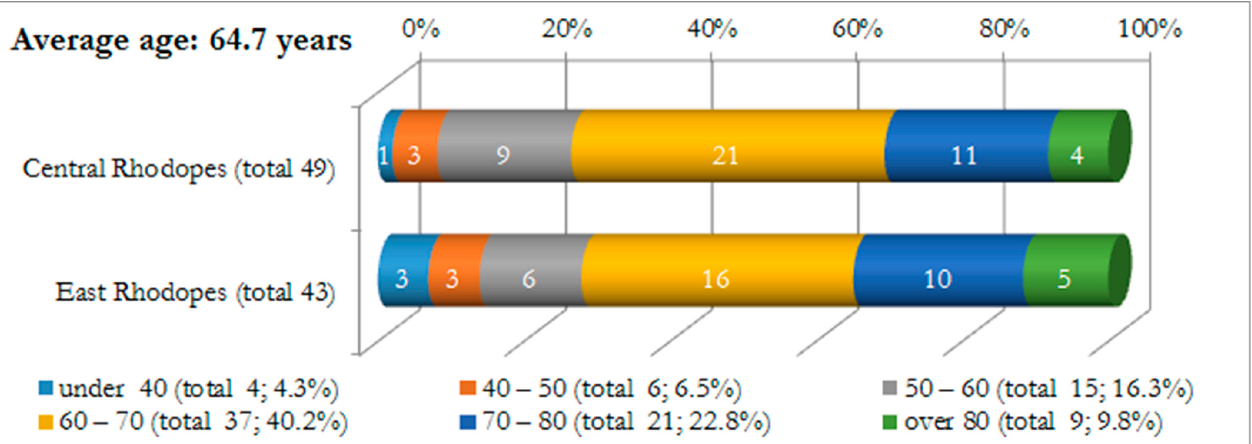
Figure 3. Demographic characteristics of informants by region and education. 3.2. Ethnobotanical Data from the Field Study A total of 114 plant species belonging to 52 families and 110 genera were reported for human medicinal purposes (Table 1; note: the informants did not specify the orchid spe- cies, they were asked about rare species, e.g., Lilium rhodopaeum , but they responded that they did not use them). Most common were species from the families Asteraceae (19 plant species or 16.7%), Lamiaceae (14 plant species or 12.3%), Rosaceae (11 plant species or 9.6%), Liliaceae (4 plant species or 3.5%), followed by Crassulaceae, Plantaginacea, Oleaceae and Solanaceae presented each by 3 plant species (or 2.6%), and the remaining 44 families include 54 spe- cies (47.4%), with two or one plant species belonging to each (Figure 4).